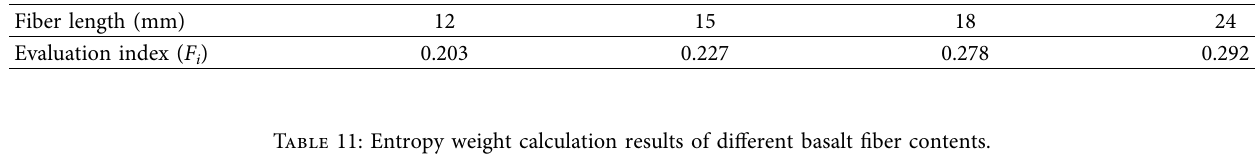
Table 10: Calculation results of evaluation index for diferent basalt fber lengths.